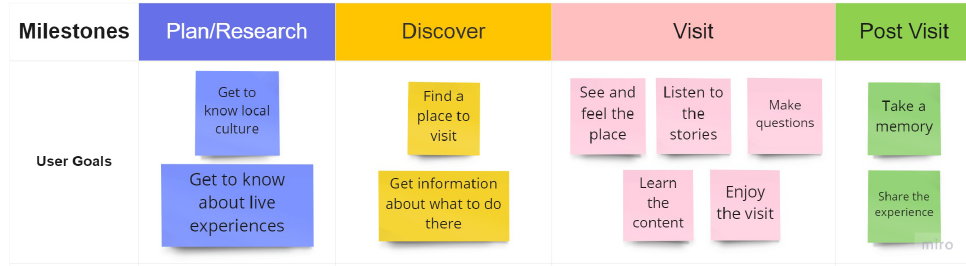
Figure 1. Milestones and User Goals of a visitor.